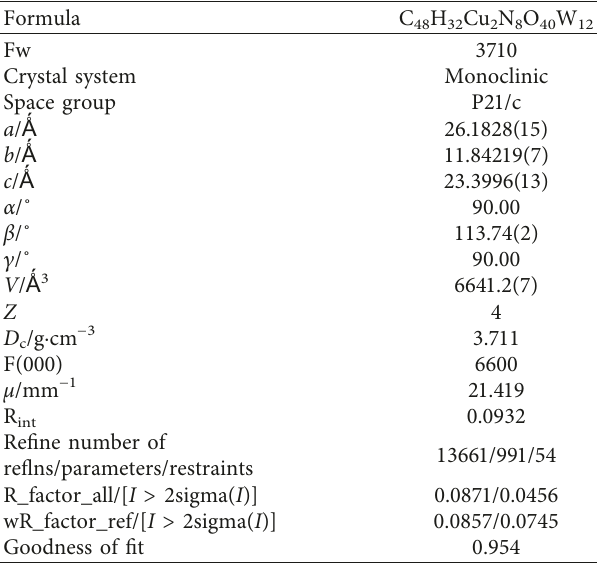
Table 1: Crystal data and structure refinements for compound 1